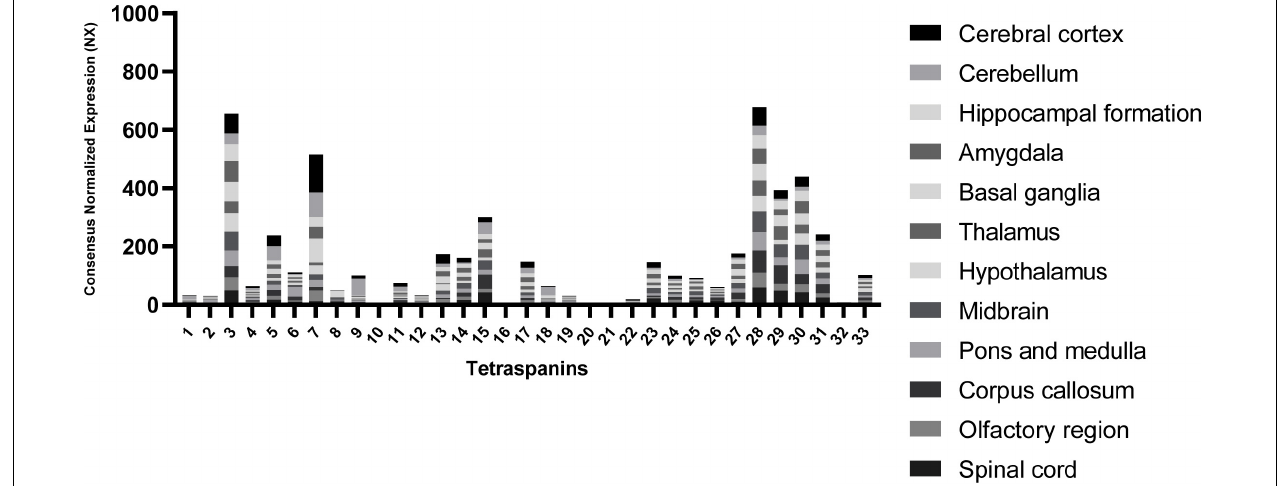
FIGURE 2 | RNA expression levels of tetraspanins in different regions of the brain. Consensus Normalized eXpression (NX) levels shown are created by combining the data from three transcriptomics datasets (HPA, GTEx, and FANTOM5) using normalization pipeline. Each bar contains combined data of all brain regions indicated. Data used to compose the graph obtained from the Human Protein Atlas database